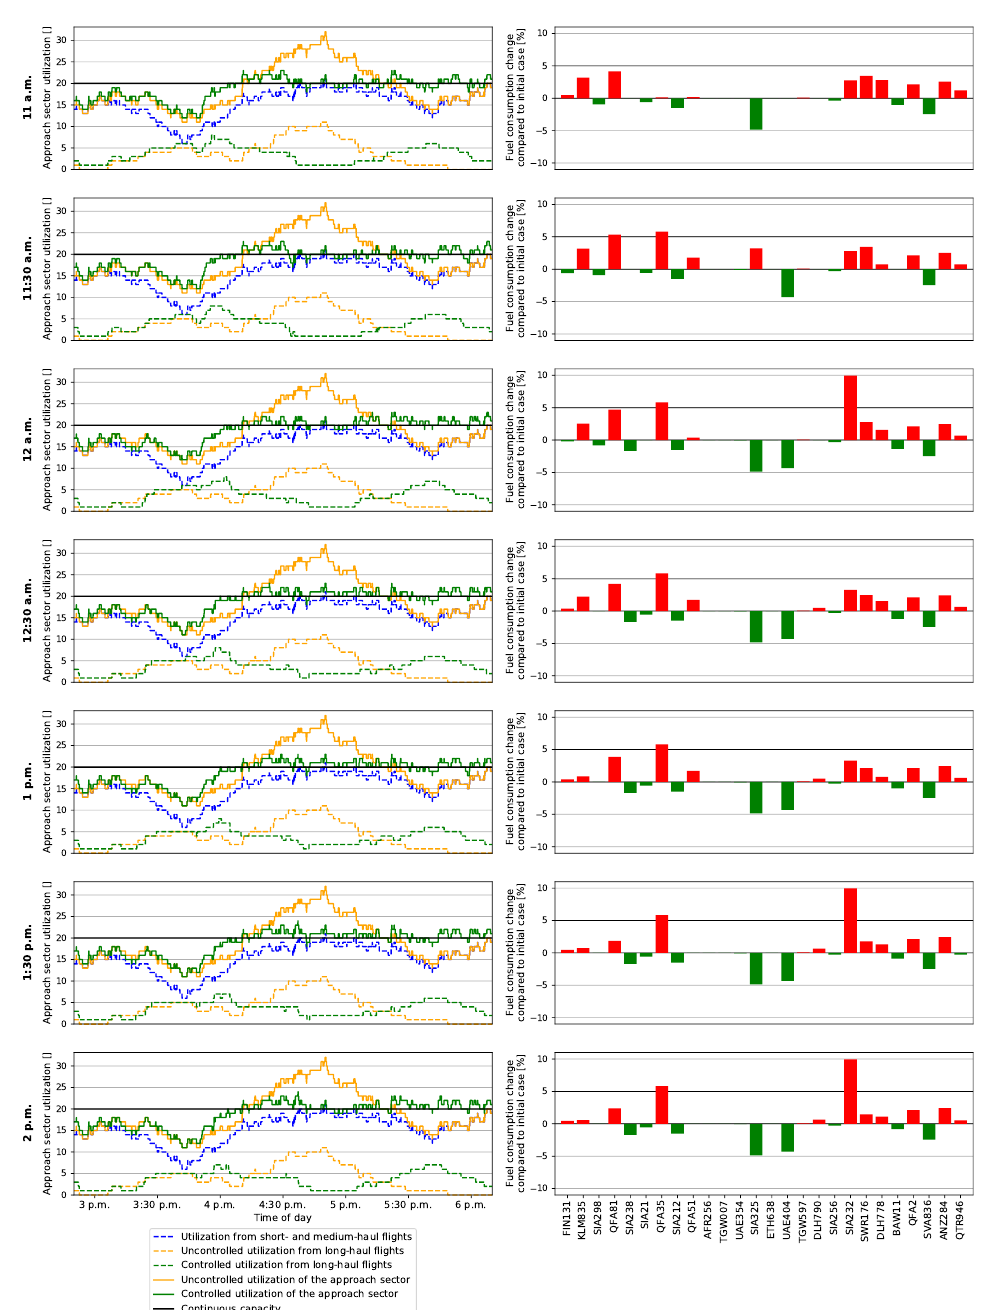
Figure 10. Left : Optimization results using LR-ATFM with speed adjustments. Right : Fuel change compared between the use of LR-ATFM with speed adjustments and the initial case with no LR- ATFM